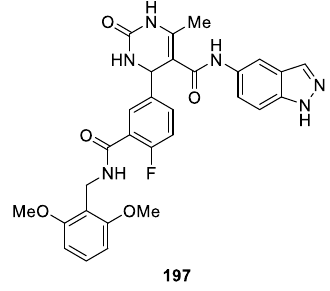
Figure 69. Chemical structure of 1 H -indazole derivative 197.